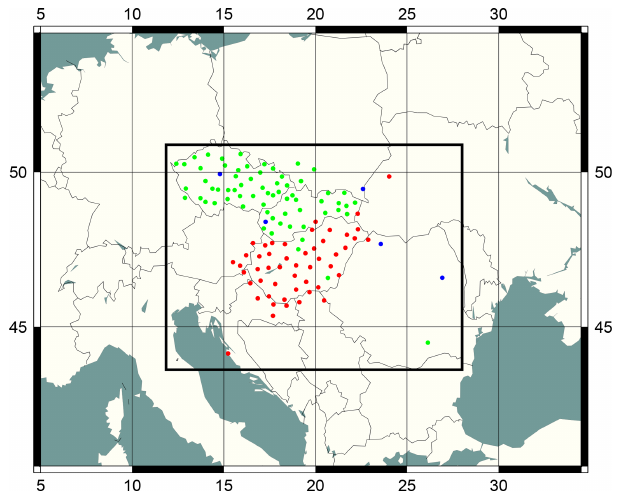
Figure 3. The computational domain (black rectangle) and prese- lected GNSS stations from SGO1 (red), GOP1 (green) and WUEL (blue) E-GVAP